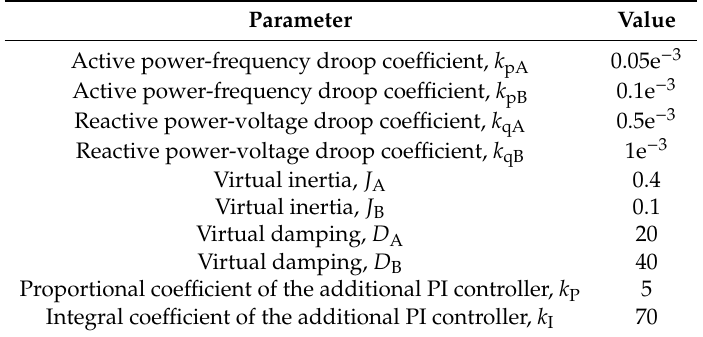
Table 5. Simulation parameter of multi-parallel self-synchronizing voltage